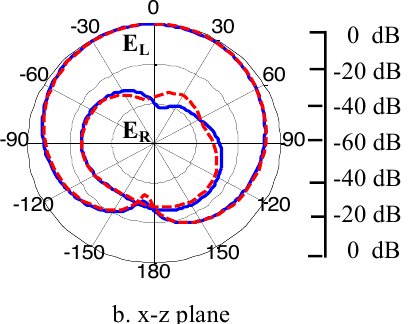
Fig. 4. The circular polarization radiation patterns of the CP on-chip antenna in x-z and y-z planes at 60 GHz.